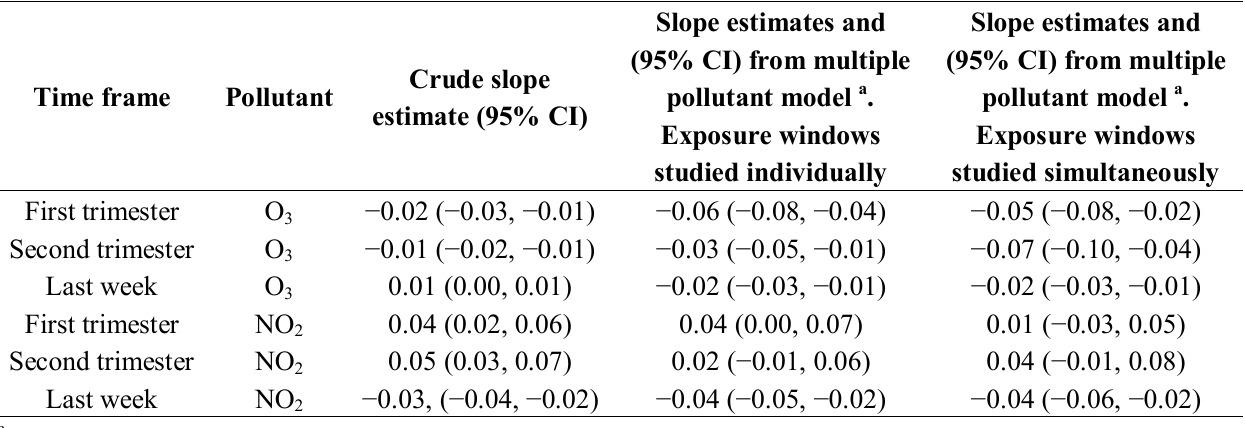
Table 5. Crude and adjusted slope estimates for duration of gestation (in weeks) per 10 µg/m 3 increase in pollutant